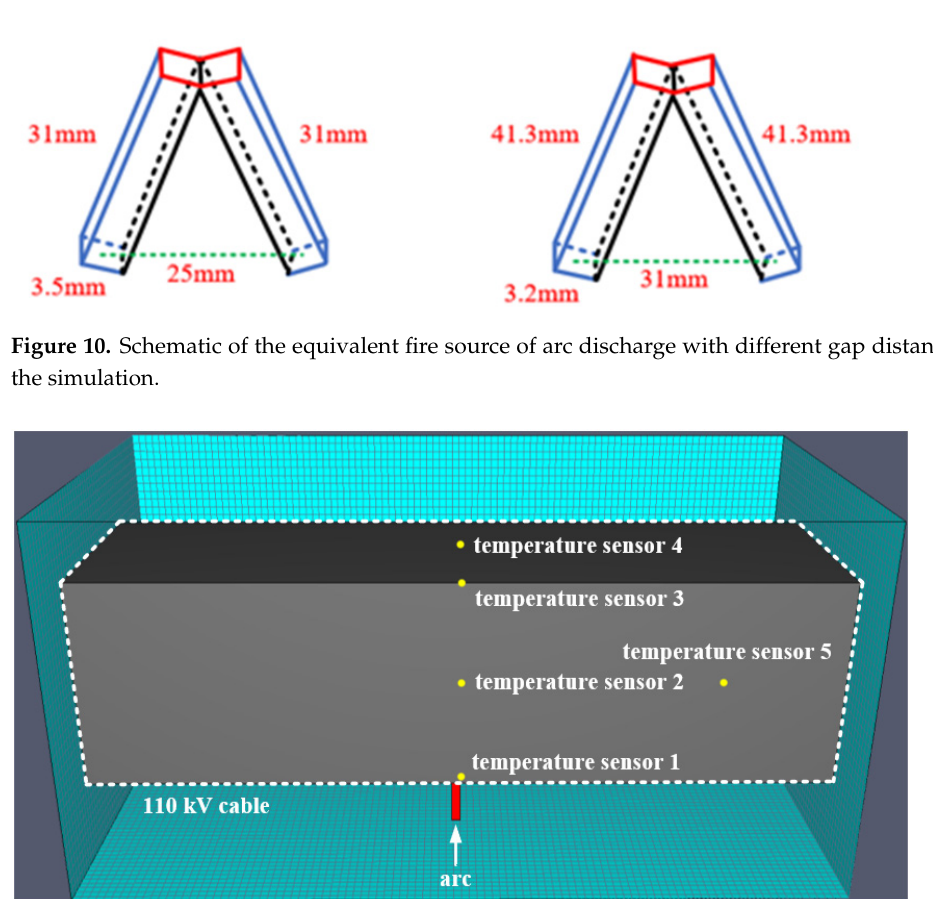
Figure 11. The model of the cable fire.